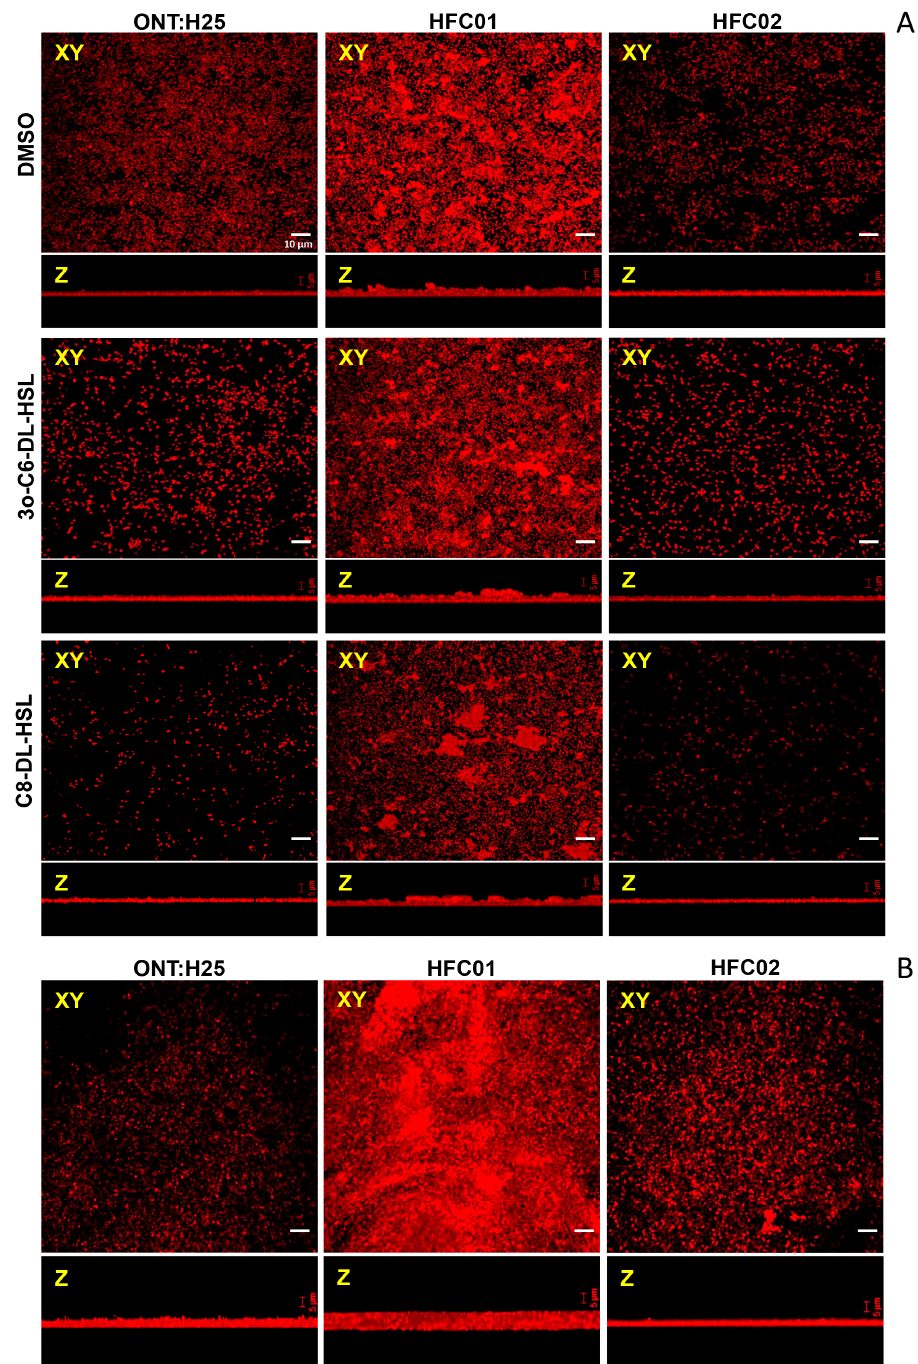
Figure 4. ( A ) Biofilm formation by ONT:H25, HFC01 and HFC02 after 24 h of incubation at 37 °C on LB supplemented with DMSO, 3O-C6-DL-HSL and C8-DL-HSL. ( B ) Biofilm formation on air-liquid-glass interface by ONT:H25, HFC01 and HFC02 after 48 h of incubation. XY — xy axis, Z — z axis from XY. Bacteria were stained with Propidium Iodide (red). 630× magnification.